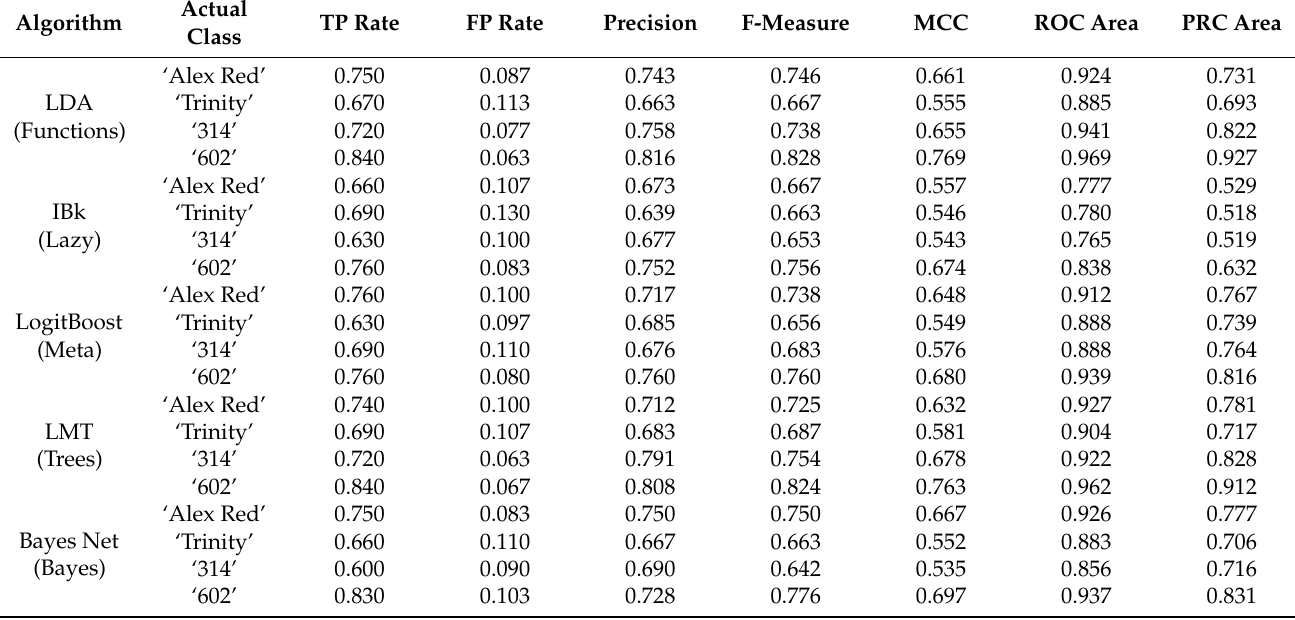
Table 7. The performance metrics of distinguishing freeze-dried red-fleshed apple cubes based on selected image